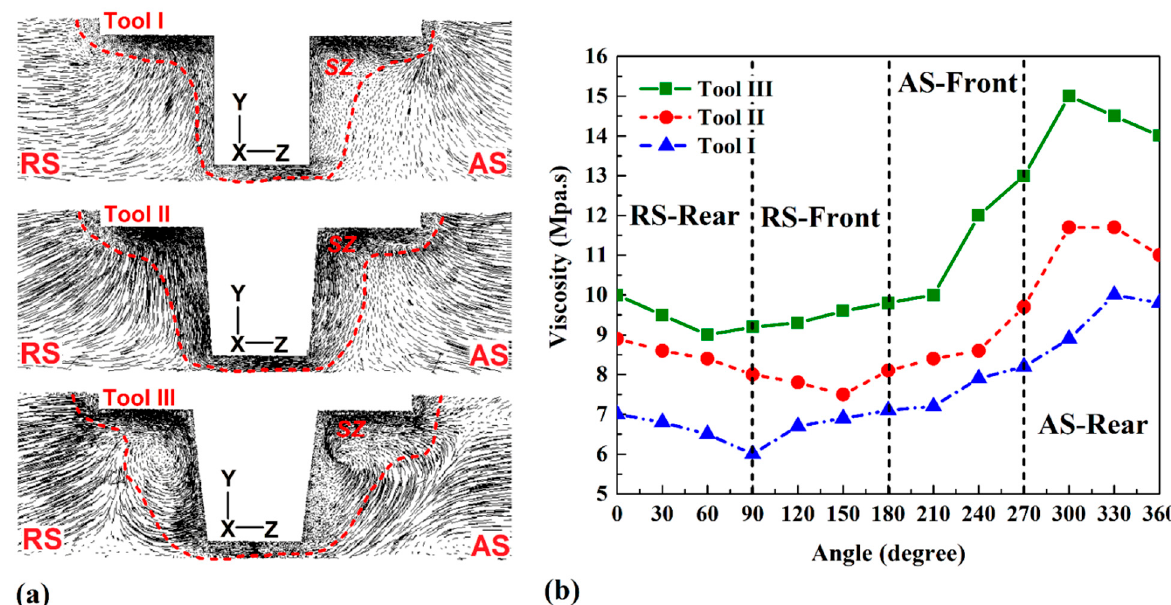
Figure 7. ( a ) cross section views of internal flow path obtained from simulation and ( b ) materials flow velocity around various tool pin.